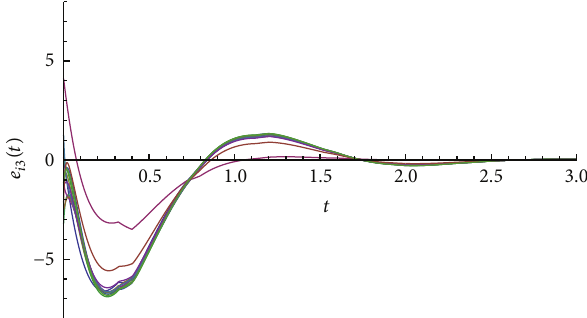
Figure4:Synchronouserror 𝑒 𝑖1 (𝑡) ofcomplexdelayednetwork(26).